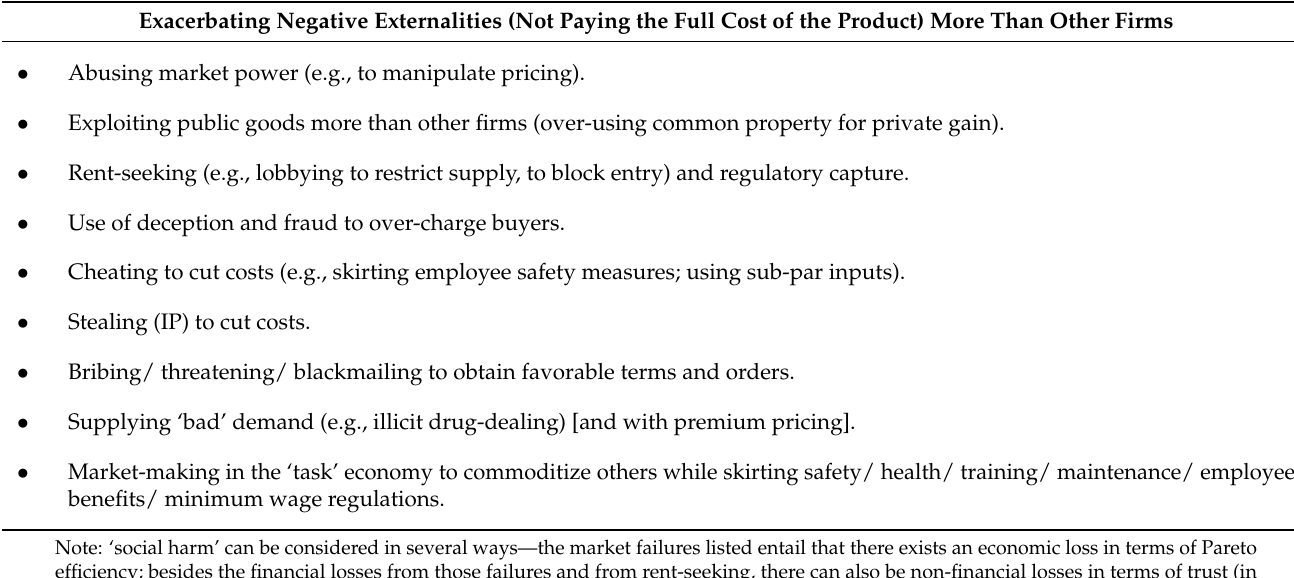
Table 1. Forms of ‘Bad’ Acts that Generate Private Benefits with Social